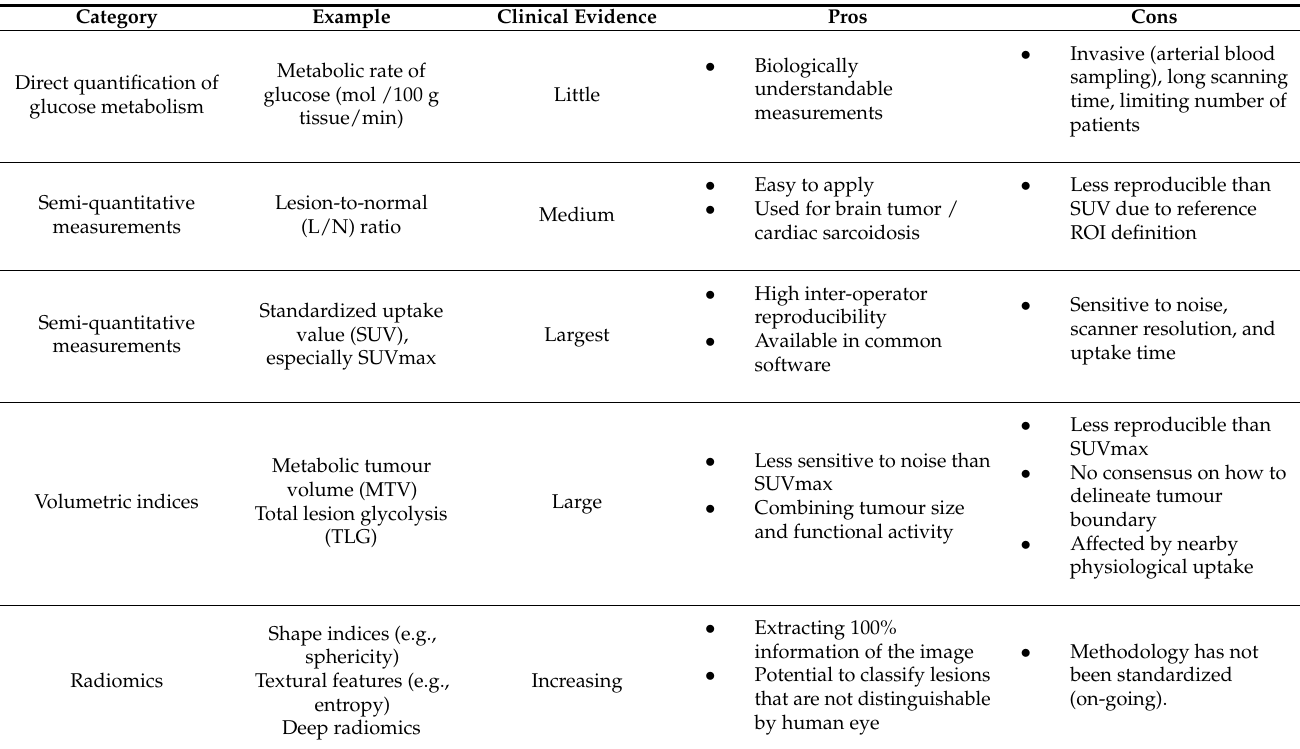
Table 1. Comparison among various quantitative measurements in 18 F-fluorodeoxyglucose (FDG) positron emission tomography